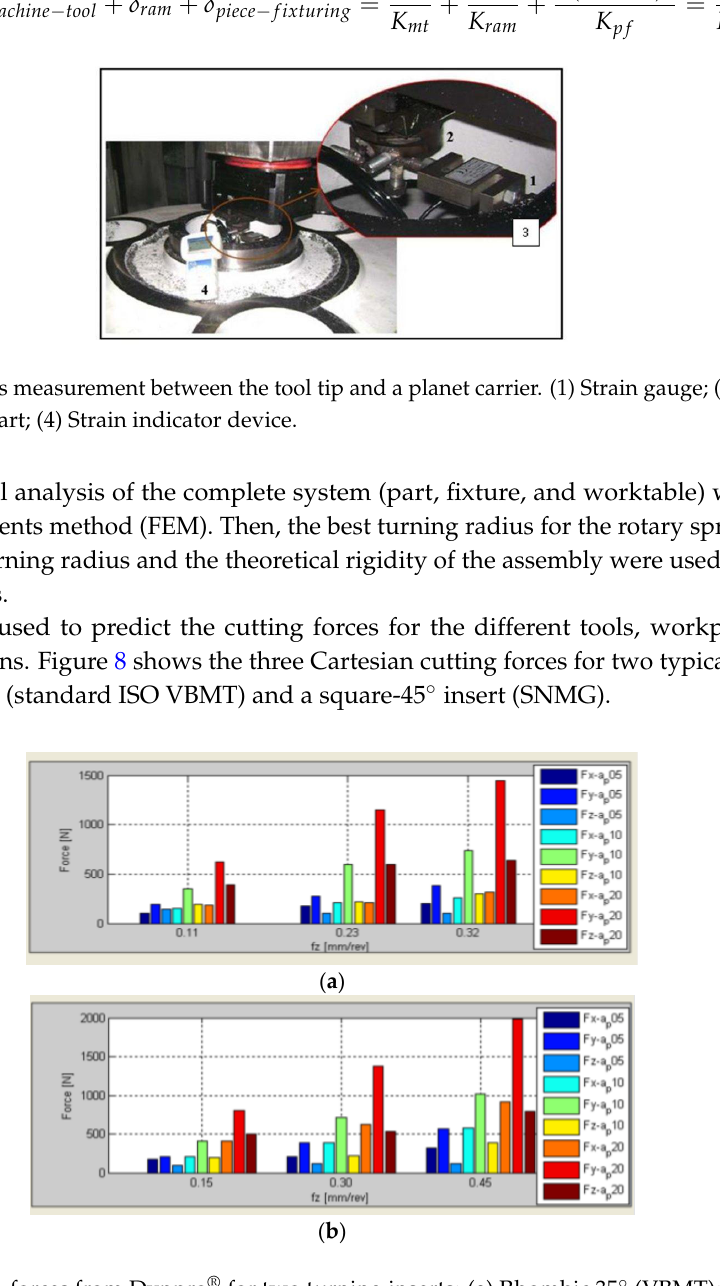
Figure 8. Cutting forces from Dynpro ® for two turning inserts: ( a ) Rhombic 35° (VBMT); ( b ) Square 45° (SNMG).